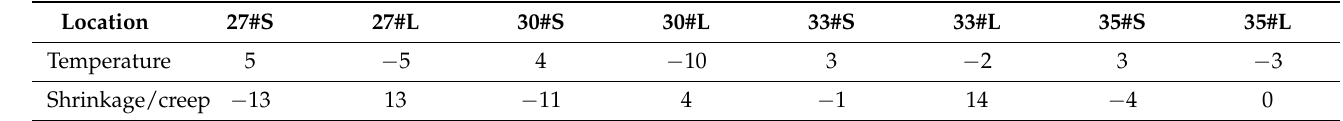
Table 3. Displacement of girder end under temperature change (rise of 10 °C) and shrinkage/creep of concrete (mm).